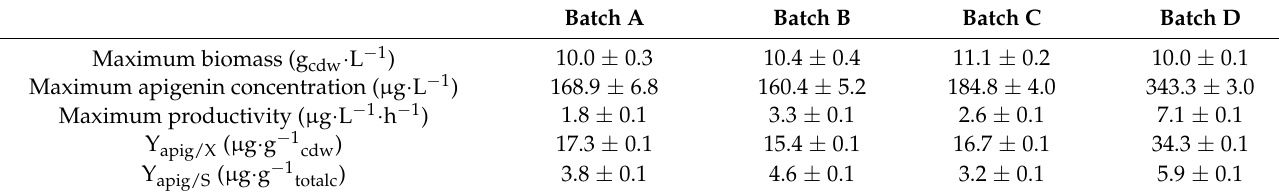
Table 2. Batch experiment